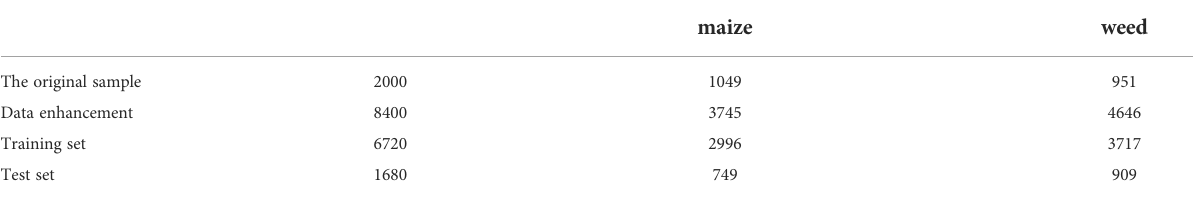
TABLE 1 Main parameters of YOLOX network